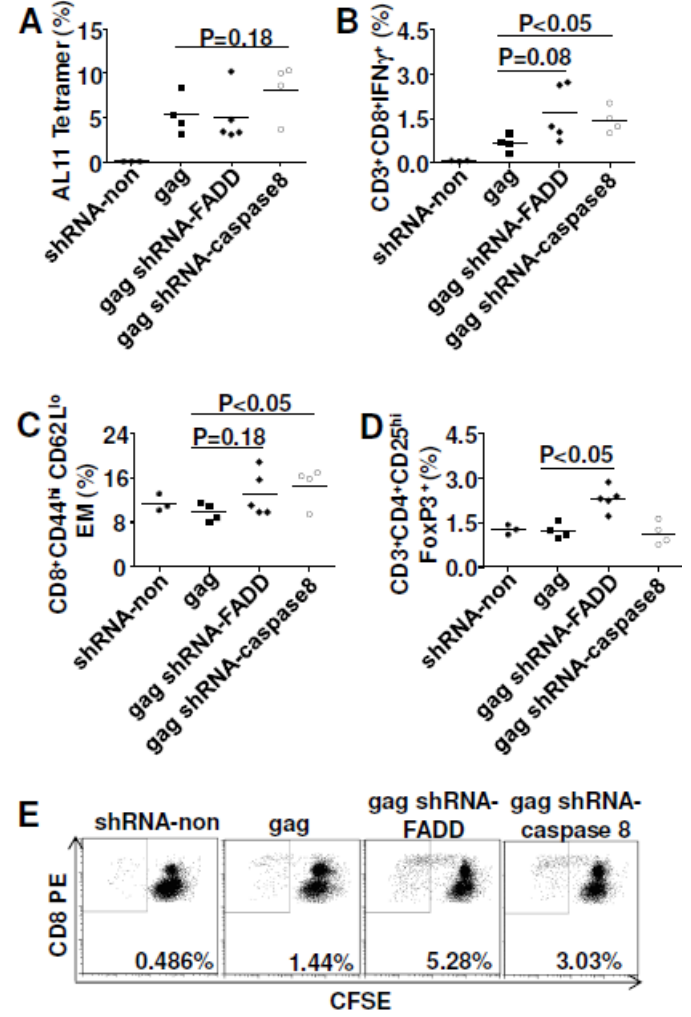
Figure 6. In vivo gene silencing of caspase 8 improved CMI responses for SIVmac Gag. C57BL/6 mice were immunized with 2 μg plasmid pJ603-gag combined with 2 μg plasmid shRNA-FADD or shRNA-caspase 8 at day 0 and day 28. Mice were euthanized 10 days